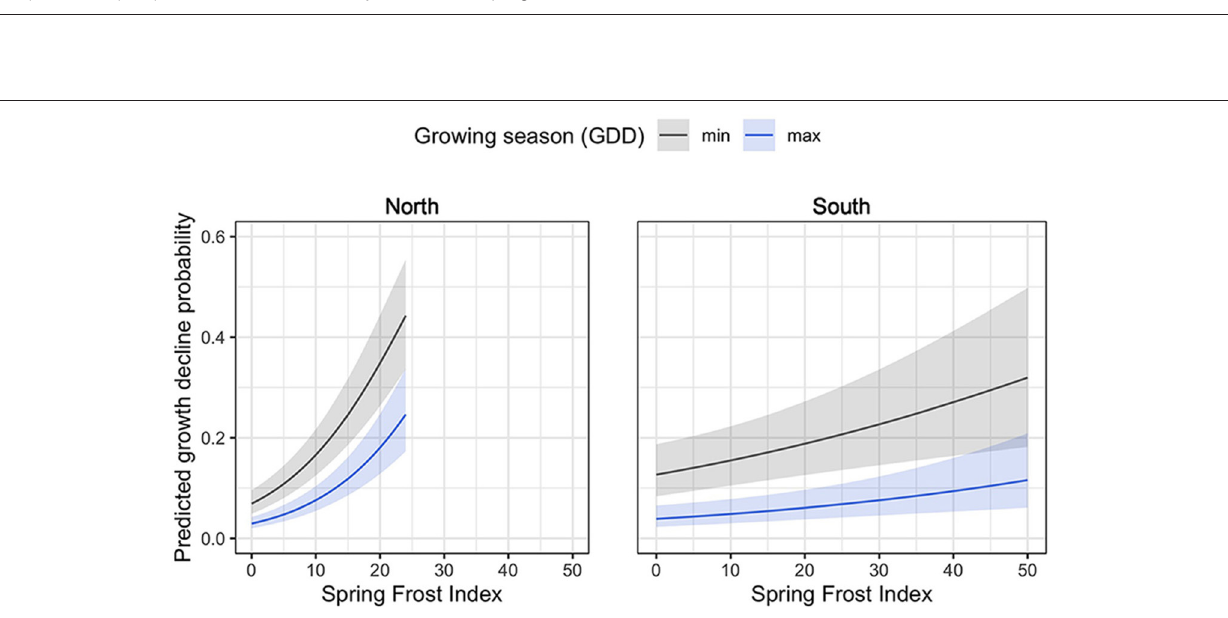
Frontiers in Forests and Global Change | www.frontiersin.org